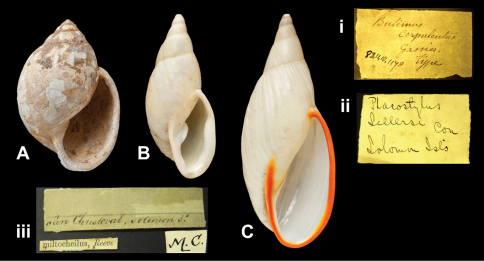
Placostylus and Aspastus species. A, i
Placostylus corpulentus (Gassies, 1871), syntype NHM 1883.11.10.1173 (H = 94.0). Reduced in size B, ii
Aspastus sellersi (Cox, 1871), lectotype NHM 2007069 (H = 44.4) C, iii
Aspastus miltocheilus (Reeve, 1848), lectotype NHM 2007072 (H = 68.3).